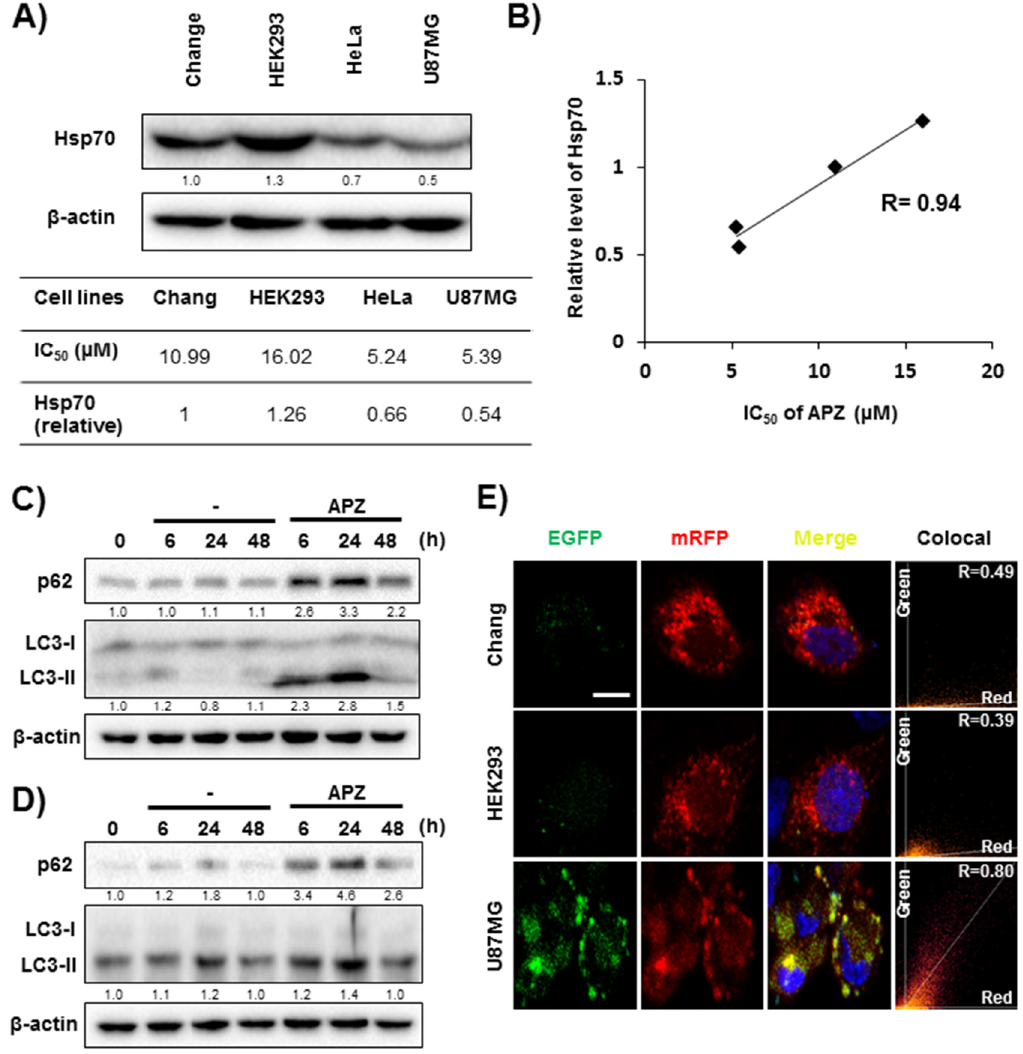
Figure 7. Efficacy of APZ is dependent on the expression level of Hsp70. ( A ) Expression levels of Hsp70 and IC 50 values from APZ treatment for 48 h both in normal cell lines (Chang, HEK293) and cancer cell lines (HeLa, U87MG). ( B ) Pearson correlation graph between IC 50 of APZ and expression level of Hsp70 in various cell lines. ( C – D ) LC3-II and p62 levels after compound treatment for 6, 24, and 48 h. APZ treatment (5 μ M) induced autophagic degradation both LC3-II and p62 levels from 24–48 h in Chang ( C ) and HEK293 ( D ) cell lines. ( E ) Autophagic flux evaluation in various cells using mCherry-GFP LC3 in the presence of APZ (5 μ M, 24 h). Representative images of merged channels are shown; scale bar, 10 μ m. Pearson coefficient for the colocalization analysis is shown. More details of western blot, please view at the supplementary materials.